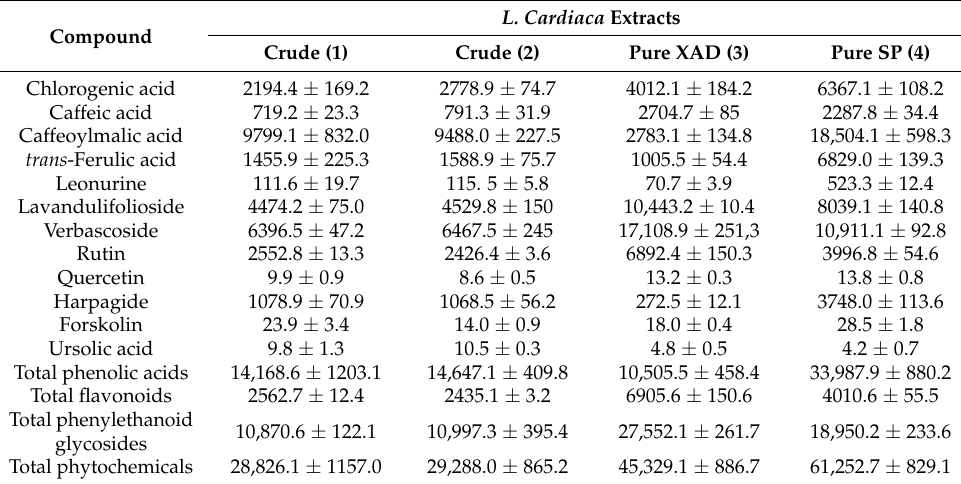
Table 2. Phytochemical content, expressed as µ g g − 1 , in different extracts of L. cardiaca .